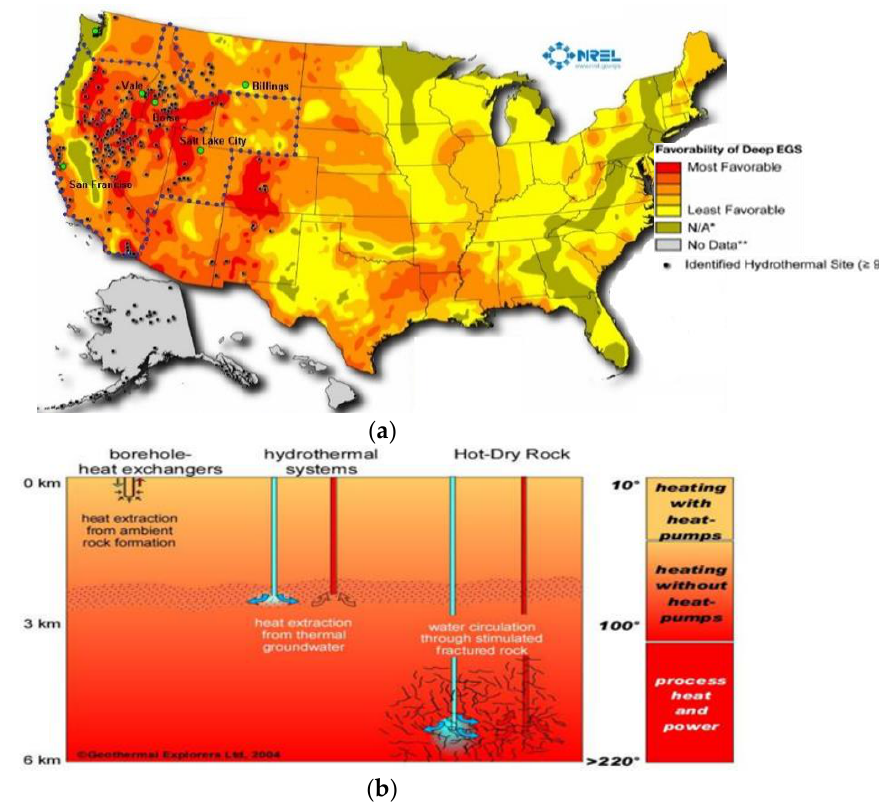
Figure 1. Geothermal resource distribution and geothermal resource extraction methods. ( a ) Geothermal resource map of the United States (Reproduced with permission from [8]), with the dotted region outlining identified hydrothermal sites. Color coding classifies favorability to enhanced geothermal systems (EGS) systems. ( b ) Relative depth and temperature range (°C) of different heat extraction methods ( Reproduced with permission from [9]).